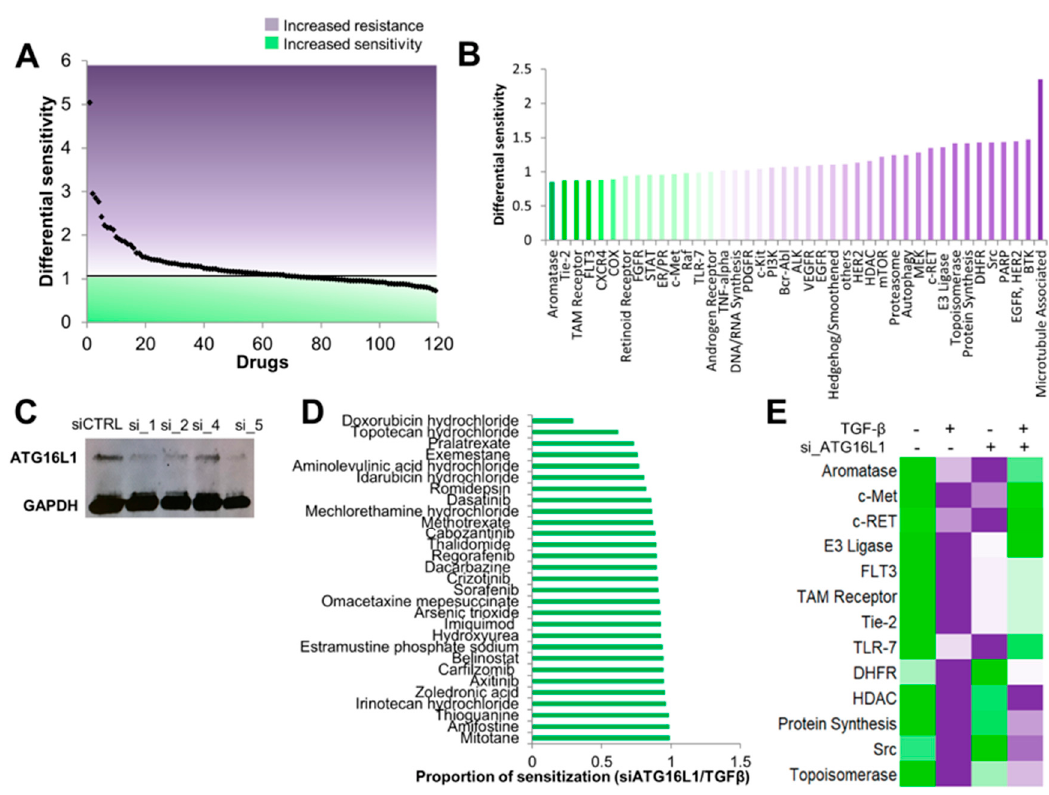
Figure 6. ATG16L1 knockdown rescues TGF- β -mediated chemoresistance. ( A ) A screen of 119 FDA-approved small molecule inhibitors demonstrated a broad increase in chemoresistance following TGF- β treatment. Each black dot represents one compound. Dots above the 1 were differentially resistant in TGF- β -treated cells as compared to vehicle-treated cells; dots below the 1 were more sensitive in the TGF- β -treated cells as compared to vehicle-treated cells. ( B ) Analysis of drug screen data by targets and pathways identified increased TGF- β -mediated resistance to several common chemotherapies, such as microtubule-associated and topoisomerase inhibitor therapies, and targeted therapies in lung cancer treatment, such as c-MET, VEGF, and EGFR (purple bars). ( C ) Knockdown of ATG16L1 by siRNAs was validated by western blotting. siCtrl = non-silencing siRNA; si_1, si_2, si_4, and si_5 are independent siRNAs targeting ATG16L1 ( D ) A549 lung adenocarcinoma cells − /+ TGF- β and − /+ siATG16_1 were screened against 119 FDA-approved compounds to identify drugs for which ATG16L1 rescued TGF- β -mediated therapy resistance. ATG16L1 knockdown re-sensitized cells to multiple therapeutic agents. ( E ) Pathway level analysis of compounds where TGF- β -mediated resistance was rescued by ATG16L1